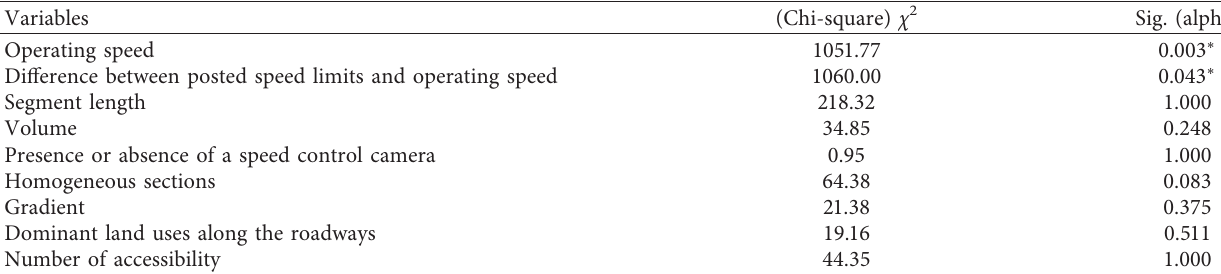
Table 5: Results of the chi-square test for examining the most effective factors in relation to the accident frequency rate. Variables